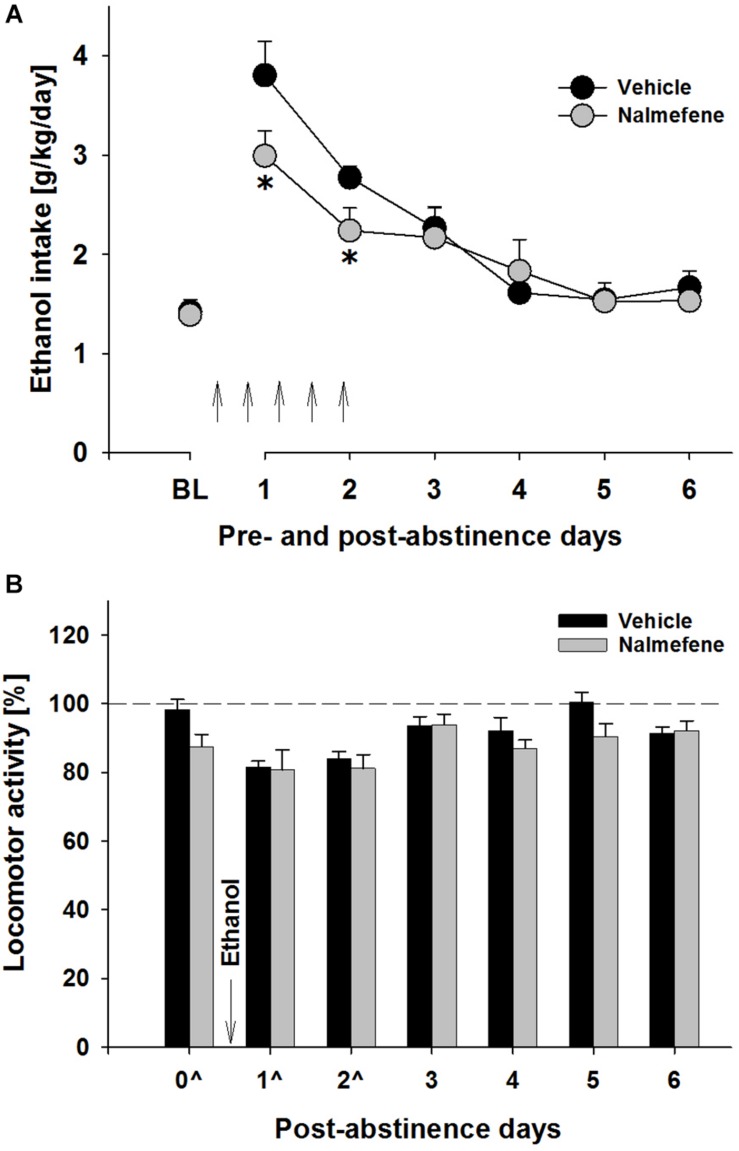
Total ethanol intake (g/kg/day) before and after an alcohol deprivation period of 3 weeks (A) and locomotor activity of the last abstinence day and the first post-abstinence days (B). Arrows indicate the administration of vehicle (n = 8) and 0.3 mg/kg of nalmefene (n = 8). A total of 5 injections were given (starting at 7 p.m. with 12 h intervals), the first injection was given 12 h before post-abstinence drinking begun. The average of the last 6 days measurements of ethanol intake is presented as the baseline drinking (BL). Locomotor activity is shown as 12-h post-injection intervals of the animals’ active phase. The percentage of each rat’s locomotor activity during and after treatment days was calculated with respect to basal activity prior to treatment (dashed line). Data are presented as means ± S.E.M. *indicates significant difference from the vehicle control group, p < 0.05.